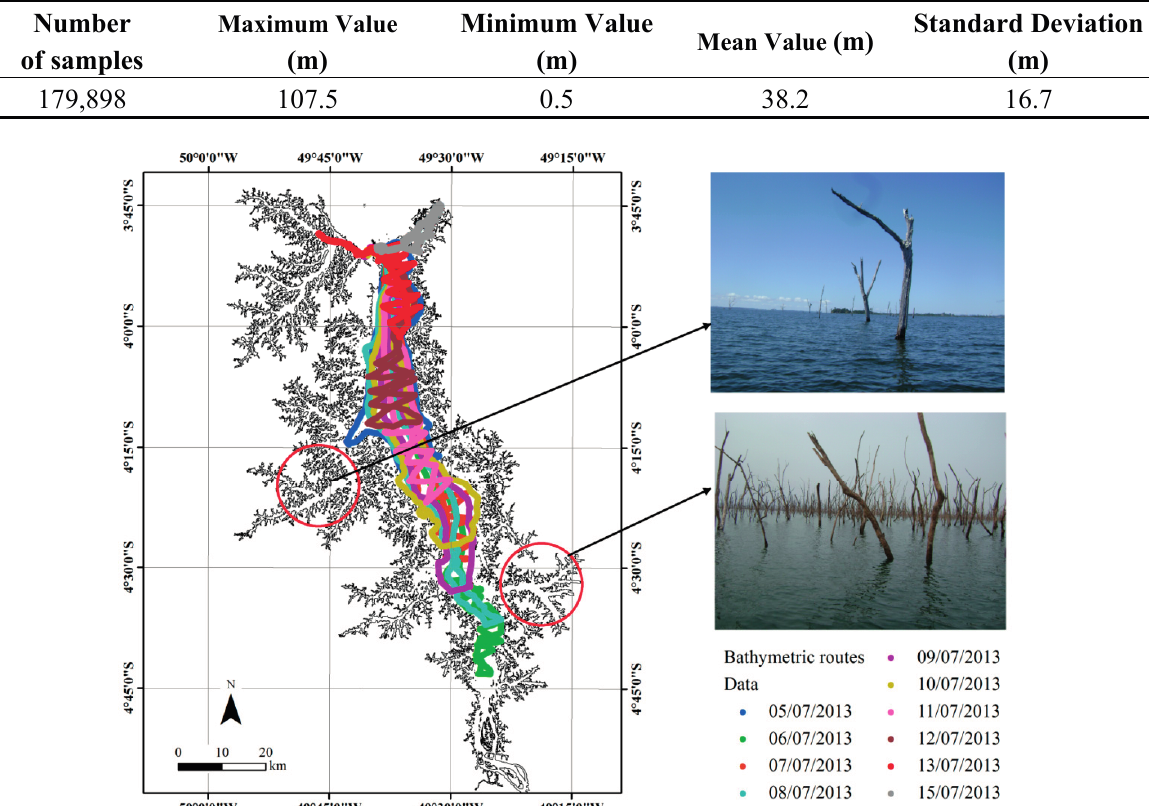
Figure 2. Bathymetric routes conducted during the field survey. The red circles indicate the locations not sampled due to difficulty of access and the presence of many dead trees. The color code indicates the acquisition